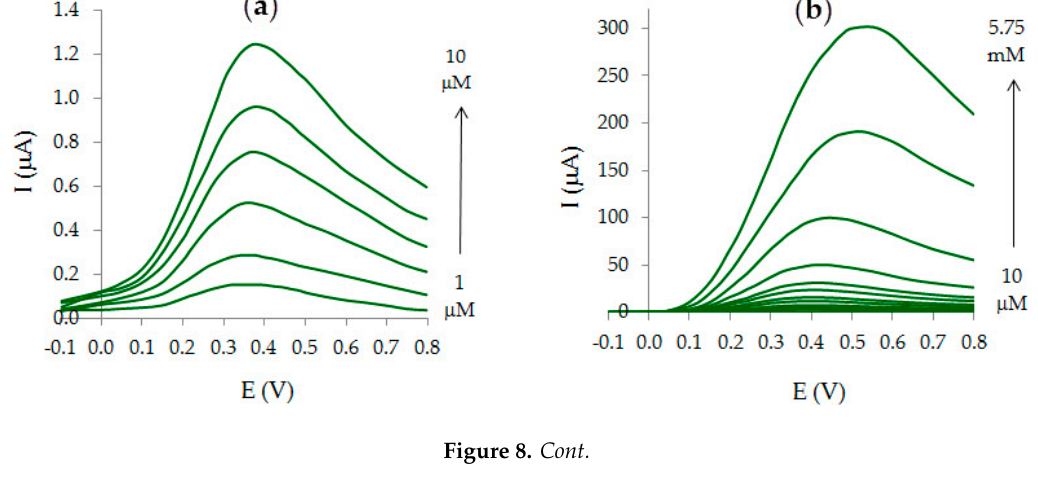
Figure 8. Cont. Figure 8.